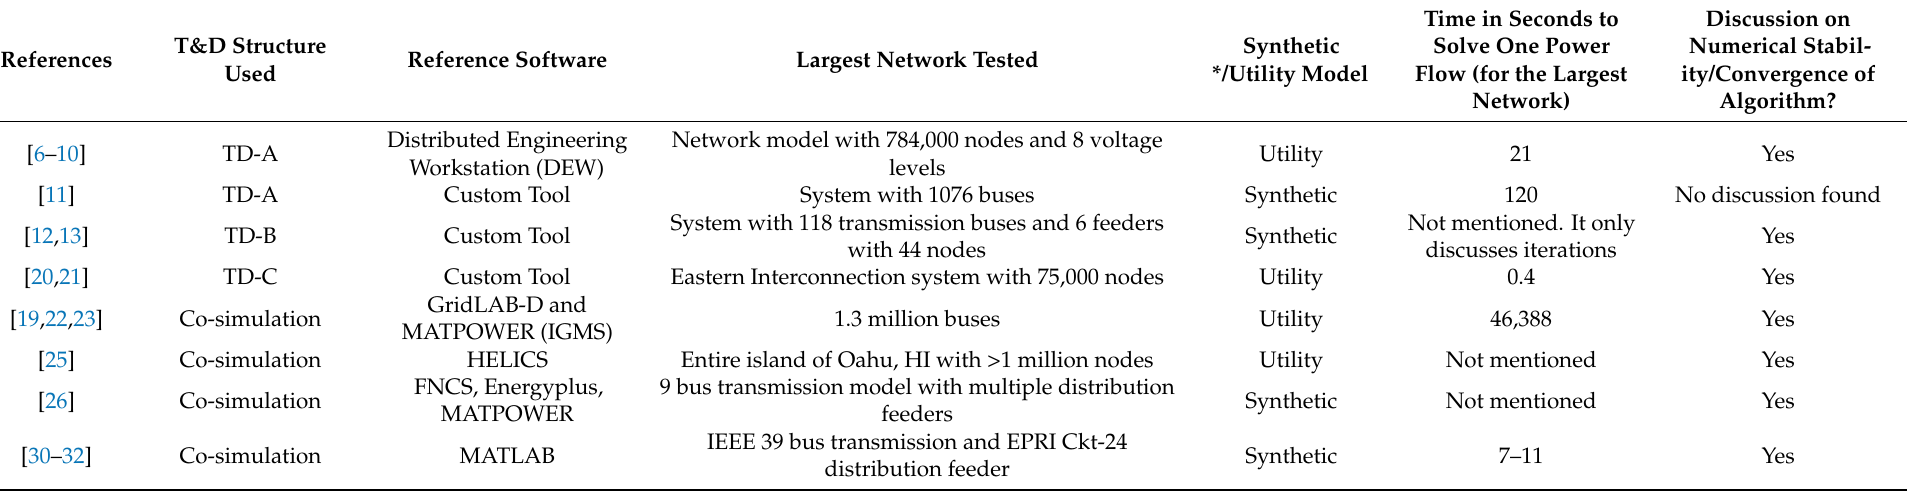
Table 2. Numerical comparison of algorithms used to model and solve the steady-state integrated T&D